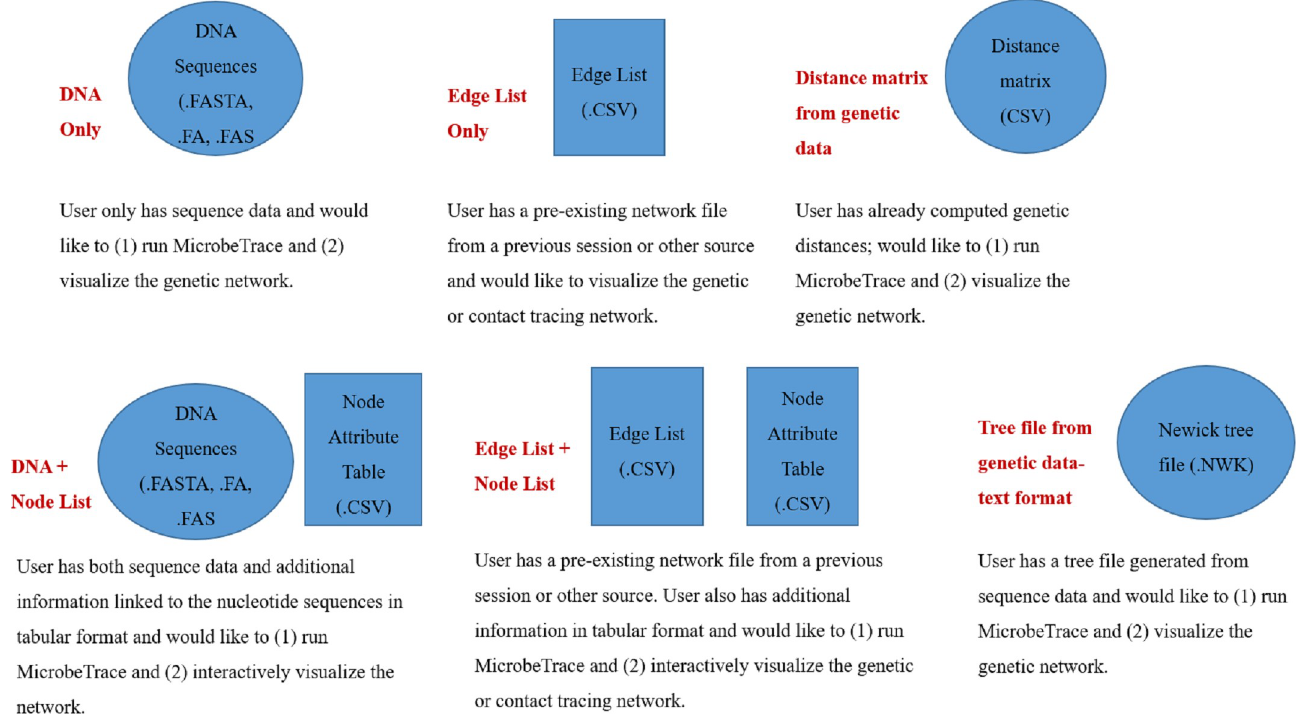
Fig 1. MicrobeTrace accepts input data in a variety of formats. This figure displays the most common use cases and their required